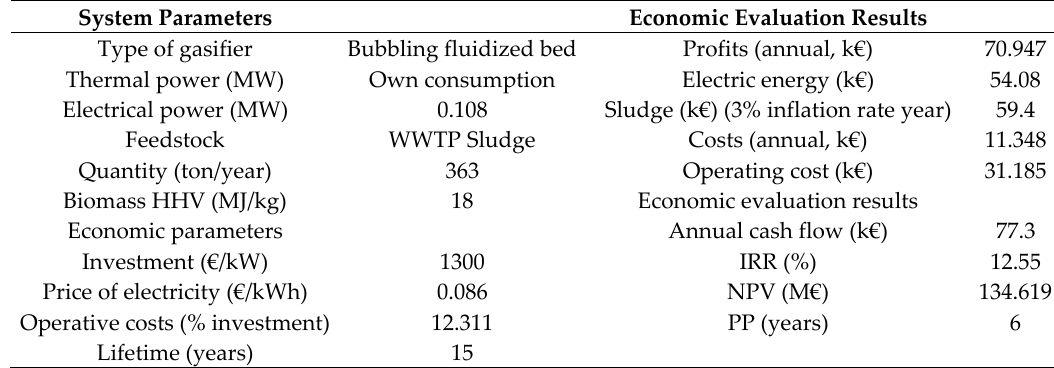
Table 5. Parameters for economic analysis and corresponding results for the construction of a gasification